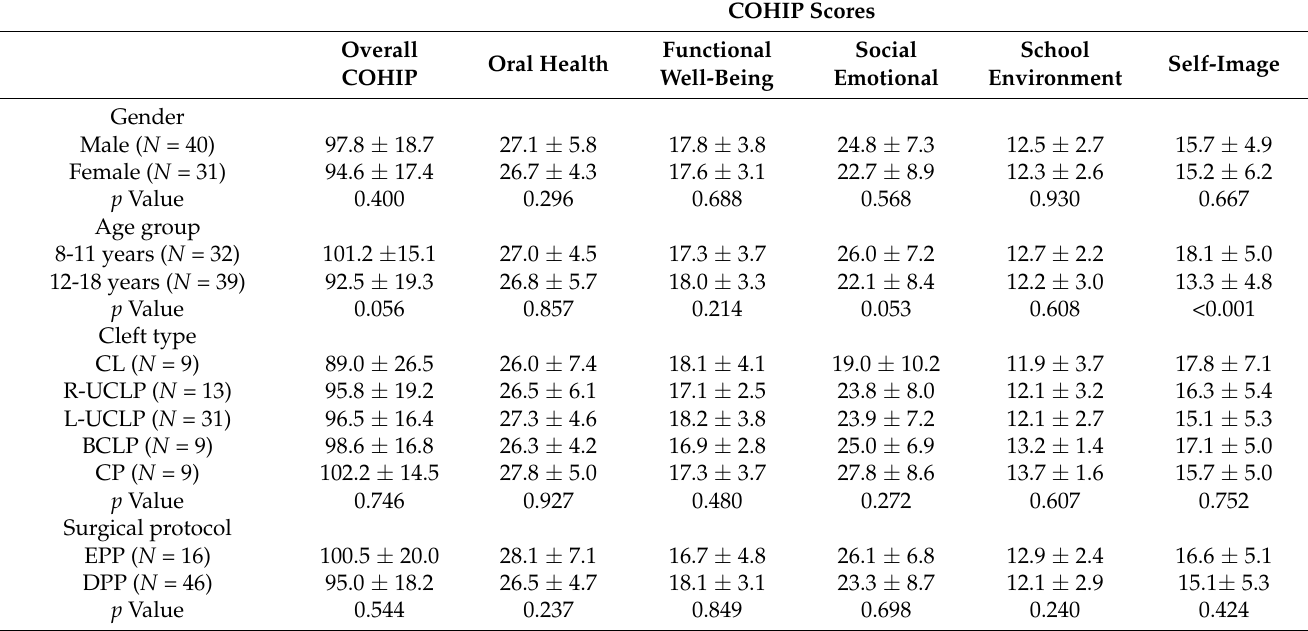
Table 5. Overall and subscale COHIP scores in cleft patients by gender, age, type of cleft, and type of surgical